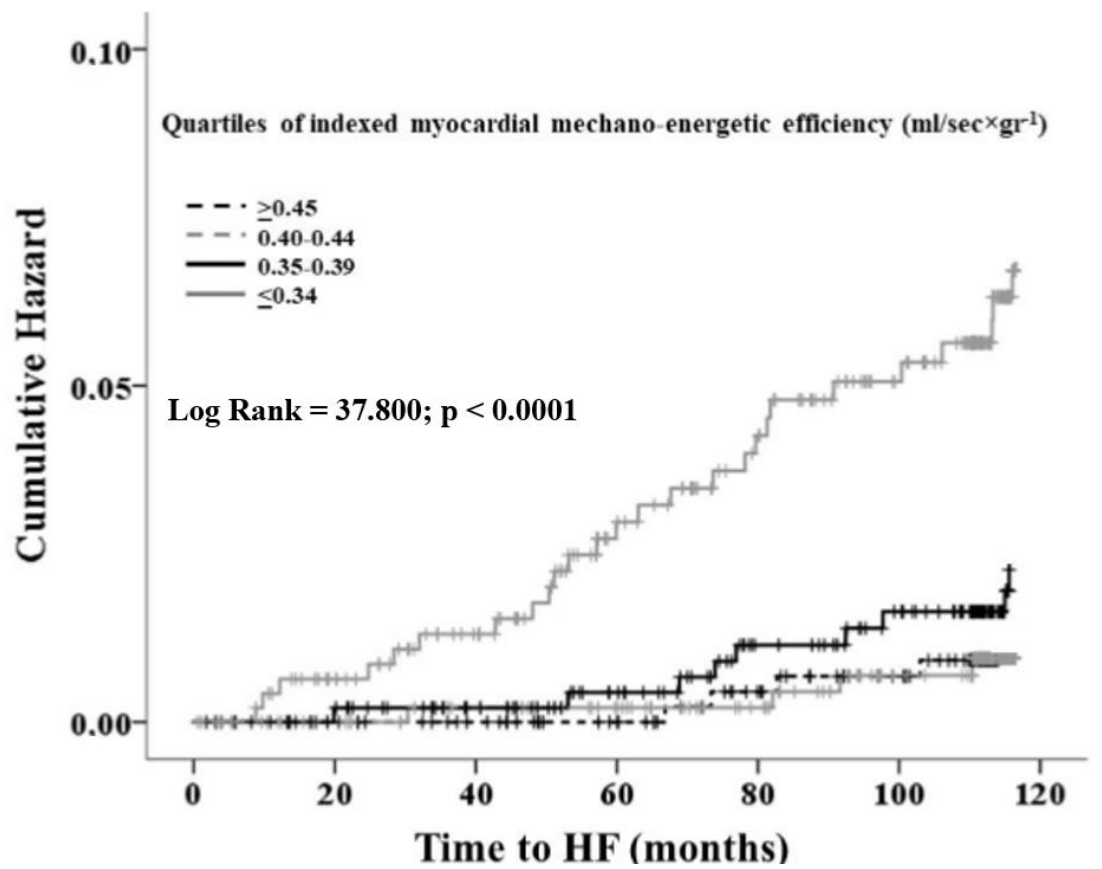
Figure 1. Cumulative hazard of incident heart failure (HF) for quartiles of myocardial mechano-energetic efficiency per unit of left ventricular mass (MEEi). Continuous grey line represents the lowest MEEi quartile. MEEi